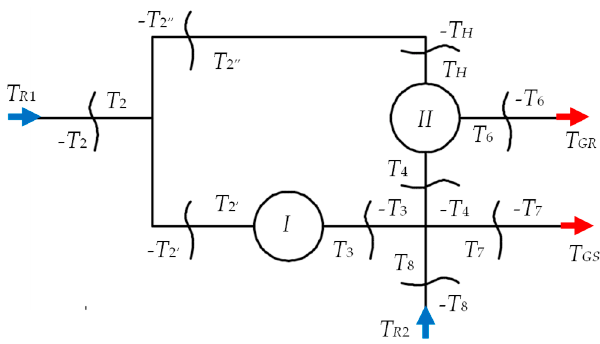
Energies 2019 , 11 , x FOR PEER REVIEW Figure 2. The conceptual scheme of a wind system containing: two counter-rotating wind rotors, a 1 degree of freedom (DOF) speed increaser and a counter-rotating electric generator.